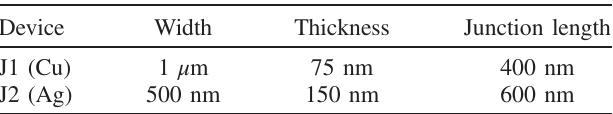
TABLE I. Wire width, wire thickness, and junction length of two Josephson junction devices based on CrO 2 nanowires. Device Width Thickness Junction